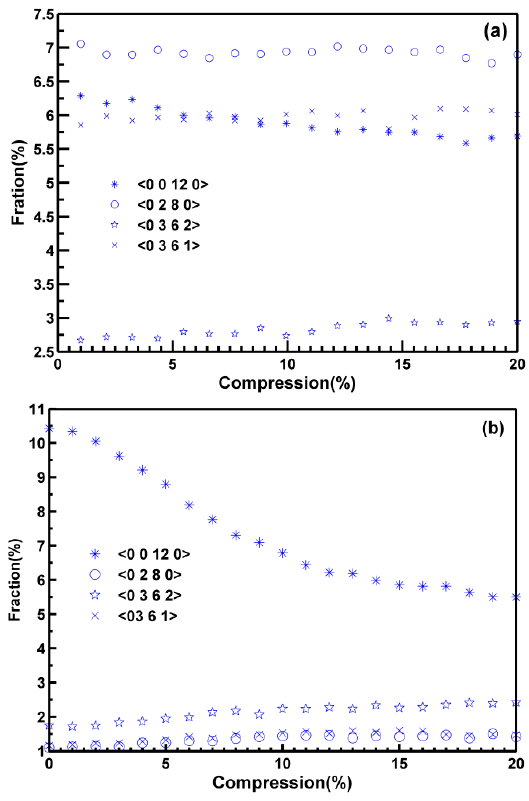
Figure 10. Change of the fraction of icosahedra in samples quenched under ( a ) 0 GPa ( b ) 25 GPa during compression.